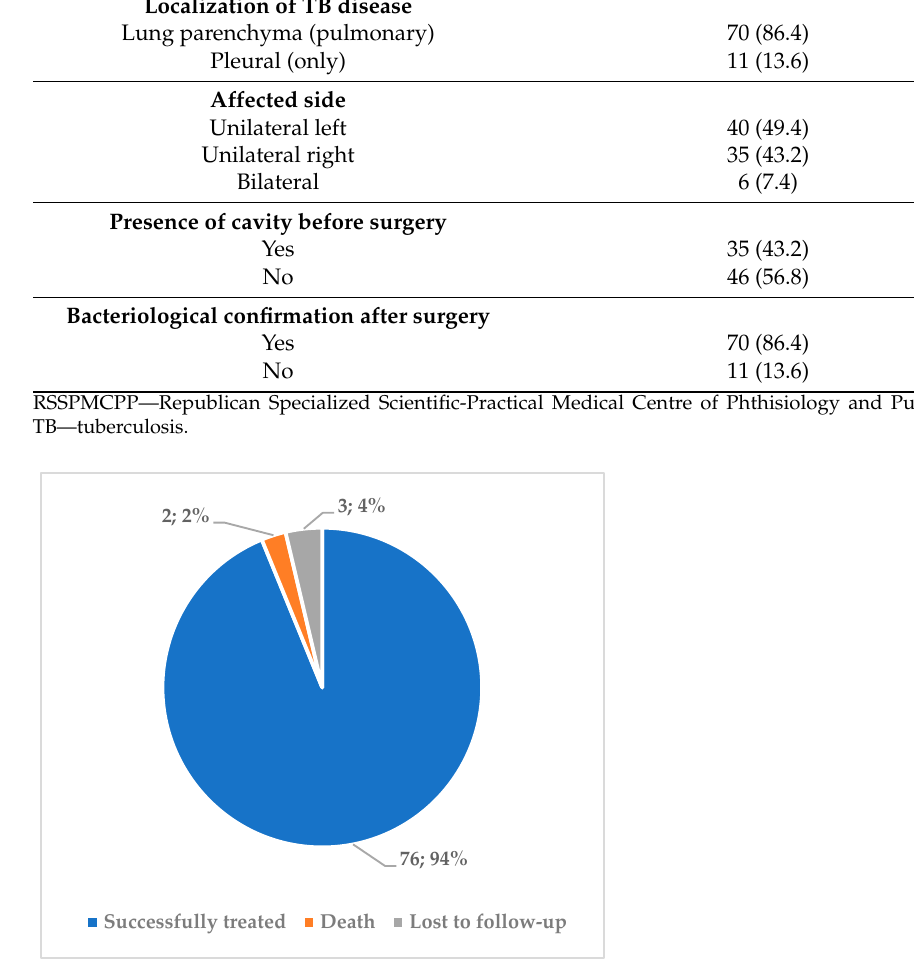
Figure 2. Treatment outcomes among 81 patients with respiratory tuberculosis who underwent adjunctive surgery at RSSPMCPP in Uzbekistan from January to May 2017. RSSPMCPP—Republican Specialized Scientific-Practical Medical Centre of Phthisiology and